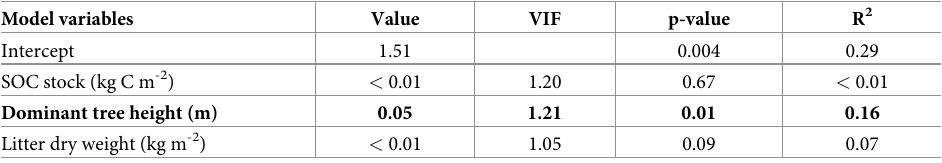
Table 5. Results of linear mixed-effects models testing the impact of biological variables on the SRref at 10˚C.